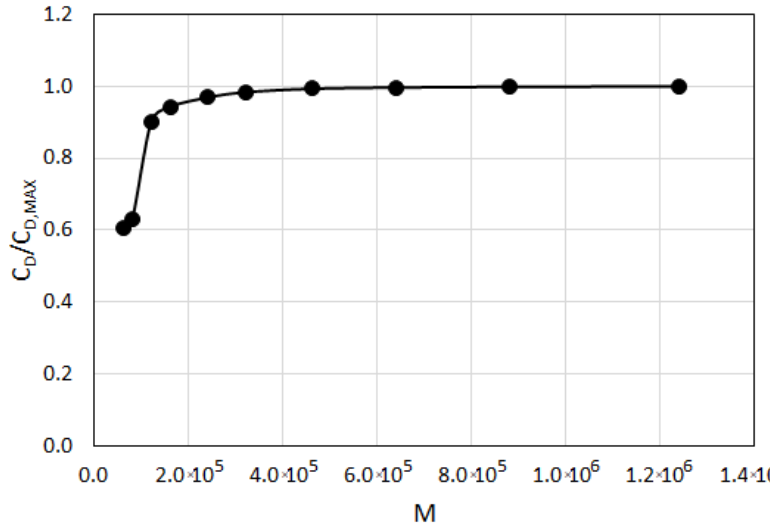
Figure 7. Variation of normalized drag coefficient with number of cells (TRI, Re = 0.01, θ ° = 0).